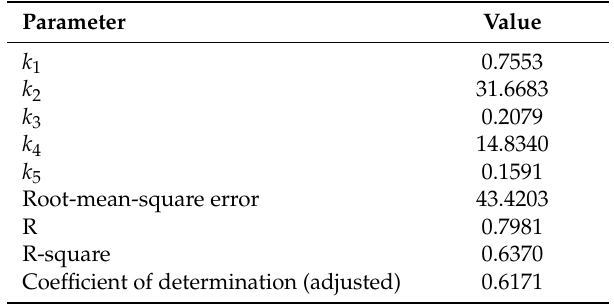
Figure 4. Relationship between Y coordinate (distance to the south of the city) and log transformed PM 2.5 concentrations at ( a ) all stations and ( b ) background stations. Table 3. Parameters of dispersion model for PM 2.5 concentrations.